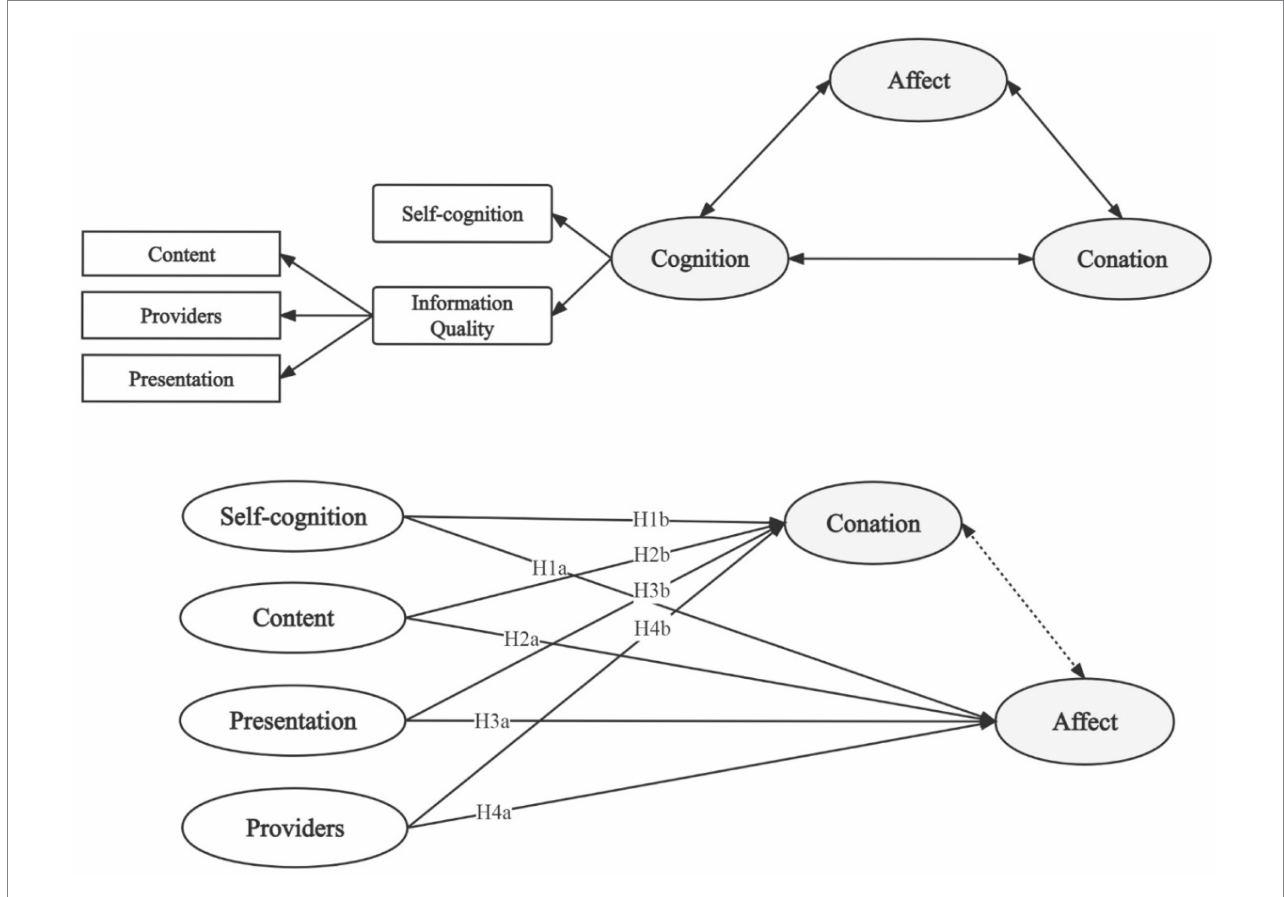
FIGURE 2 Research